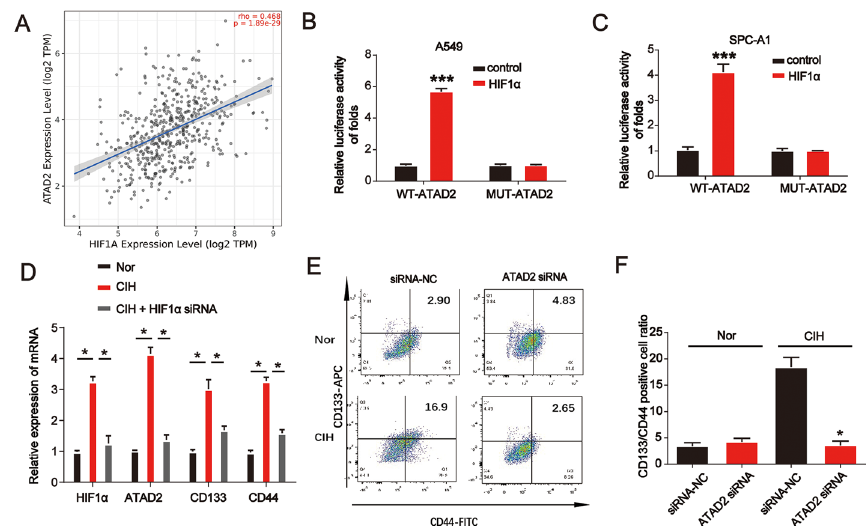
Fig. 5 CIH-induced HIF-1α activated ATAD2 during lung cancer progression. A Gene correlation between ATAD2 and HIF-1α in LUAD determined by consulting http:// timer. comp- genom ics. org/. B , C Analysis of ATAD2 promoter activity. Cells were transfected with the HIF-1α-FLAG or control plasmid for 24 h. A549 and SPC-A1 cells were transfected with an ATAD2 promoter plasmid or a plasmid containing a mutated ATAD2 promoter sequence for another 24 h. D HIF-1α, ATAD2, CD133, and CD44 mRNA expression levels in A549 cells incubated under normoxia, CIH, or CIH combined with HIF-1α. E , F Flow cytometry analysis of A549 cells transfected with siRNA-NC or siRNA-ATAD2 under normoxia or CIH. Error bars indicate mean experiments performed in triplicate. * p <